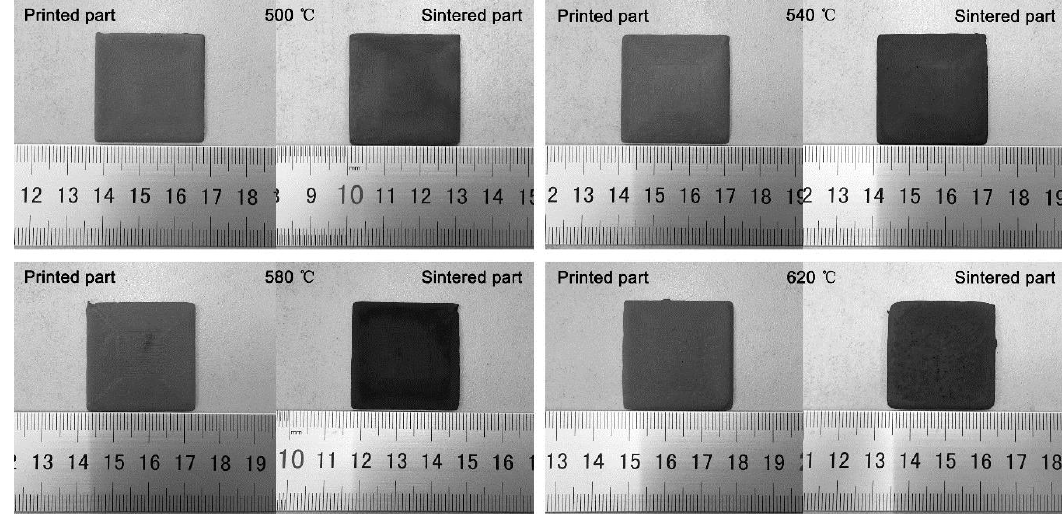
Figure 5. Comparison of printed parts before and after sintering at different sintering temperatures.